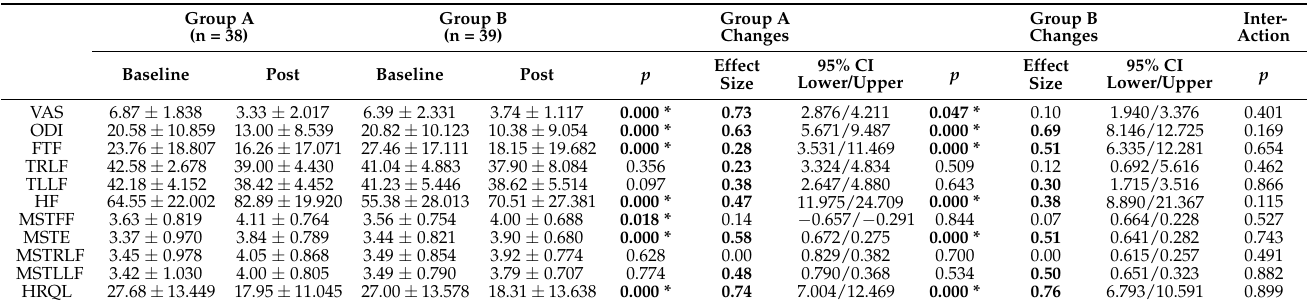
Table 3. The outcome changes in both groups after two weeks of intervention (confidence interval 95%, mean ±